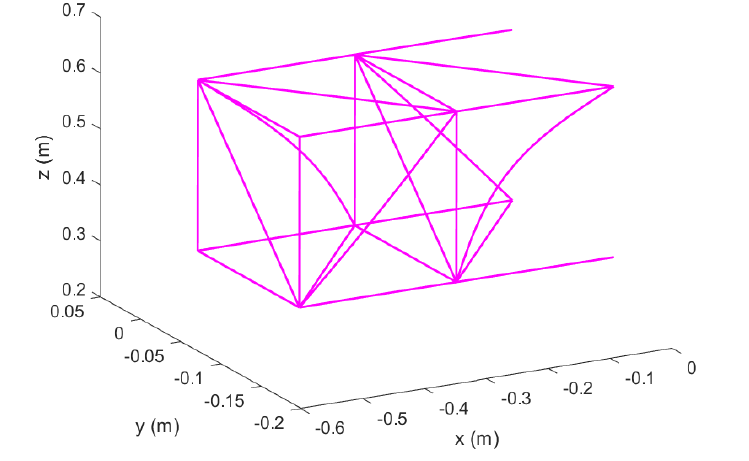
Figure 30. Mode 5 of Timoshenko beams in Topology 1 with hinged ends; original